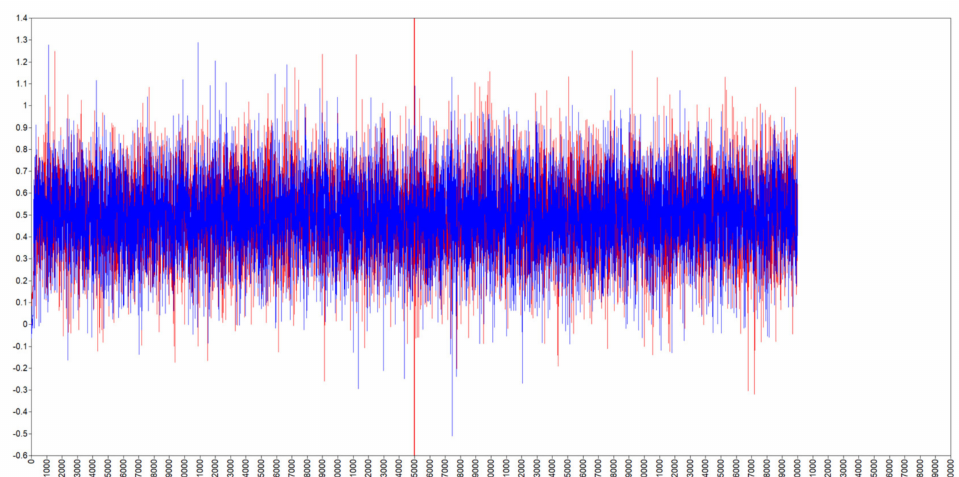
Figure 1. The chain-mixing trace plot for general emotional load on daily need satisfaction of competence.